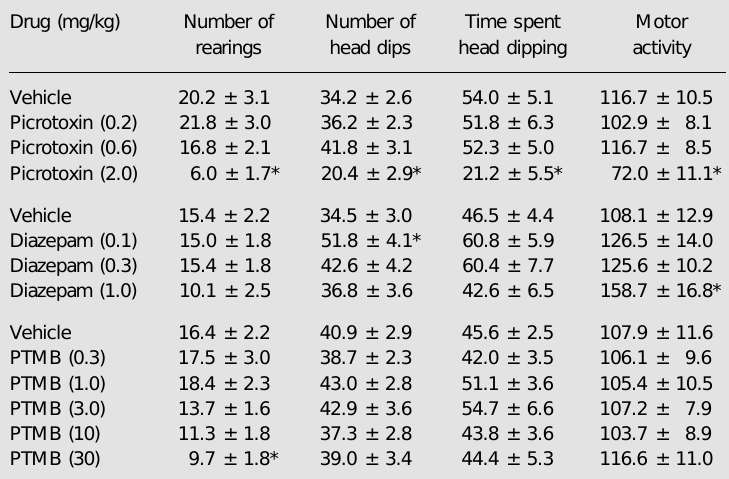
Table 1 - Effect of picrotoxin, diazepam and 4-phenyl-2-trichloromethyl-3H-1,5-benzodi- azepine hydrogen sulfate (PTMB) on the behavior of mice in the holeboard